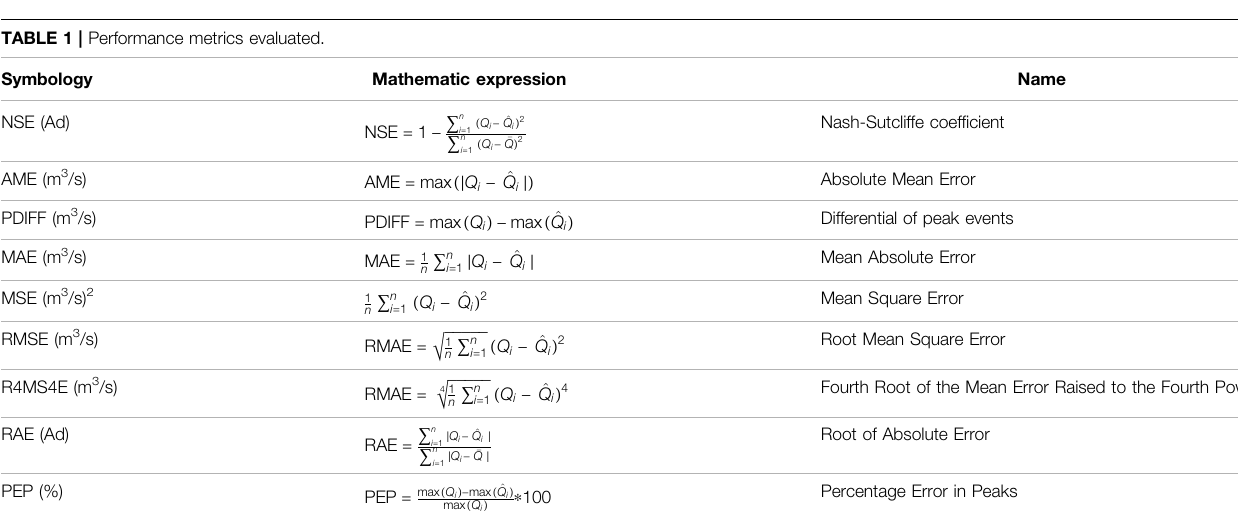
TABLE 1 | Performance metrics evaluated. Symbology Mathematic expression